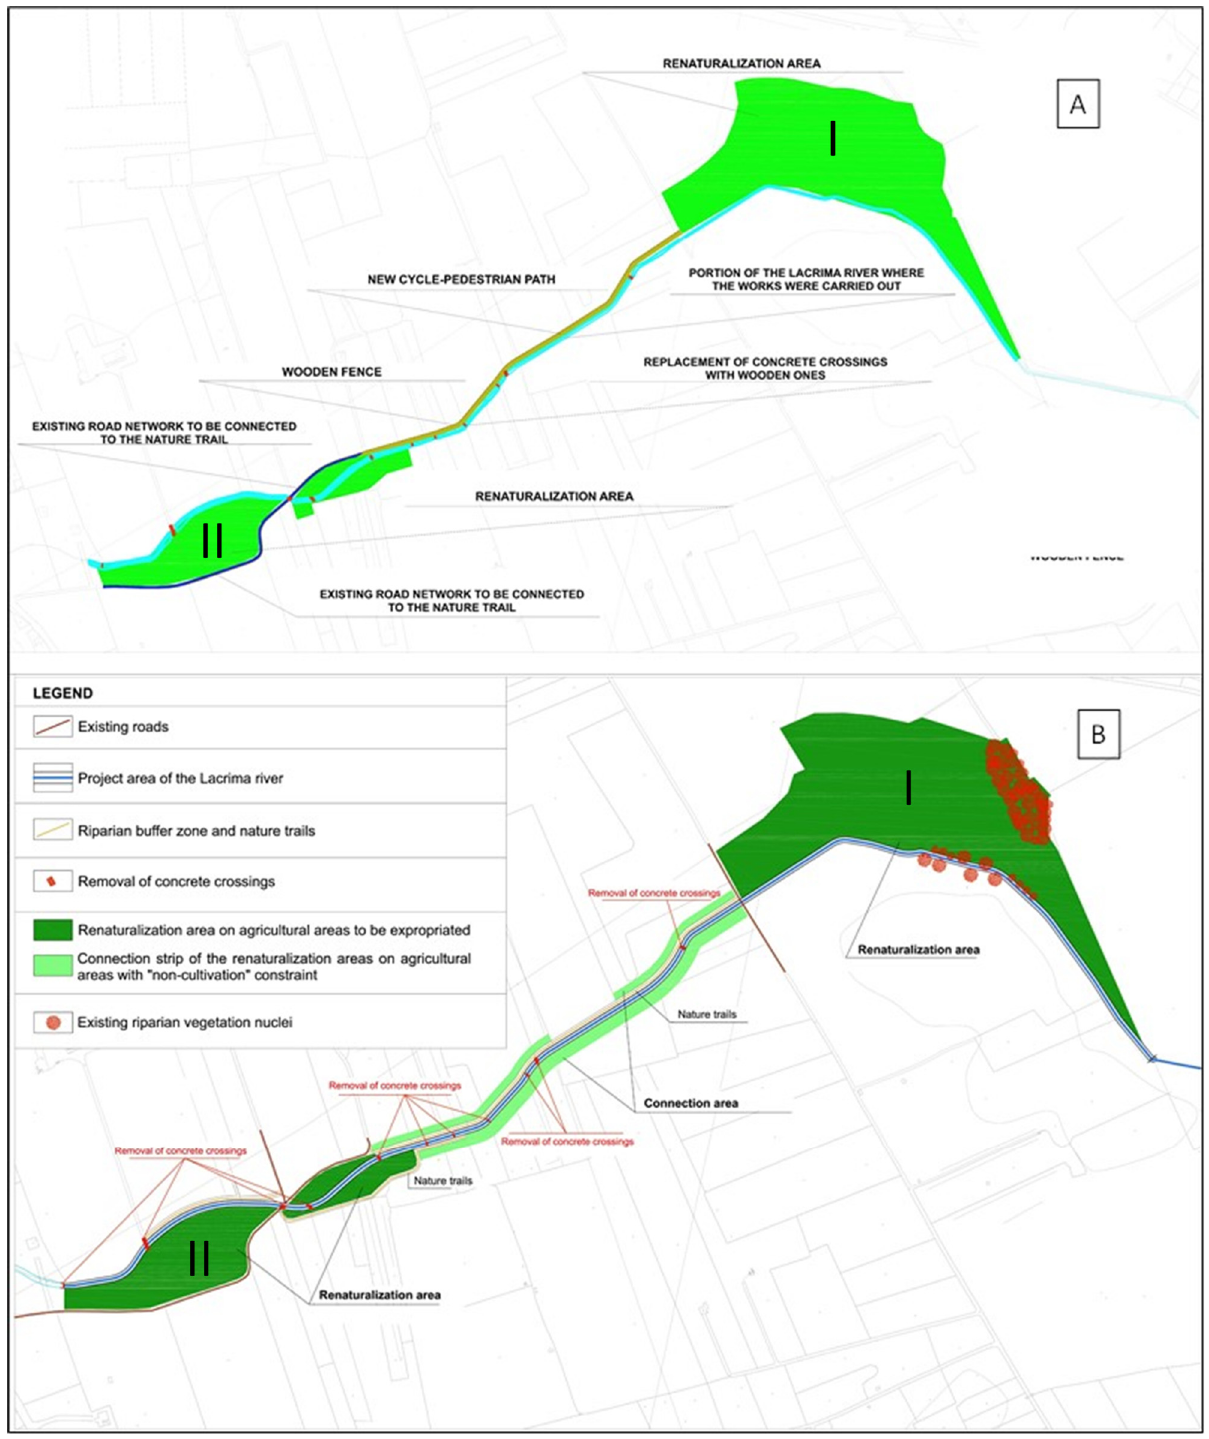
Figure 6. Plan of the ecological restoration project. ( A ) First draft of the project and ( B ) second evolution of the project. In Table 3, the frequency (quantity) of each species used for riparian forest